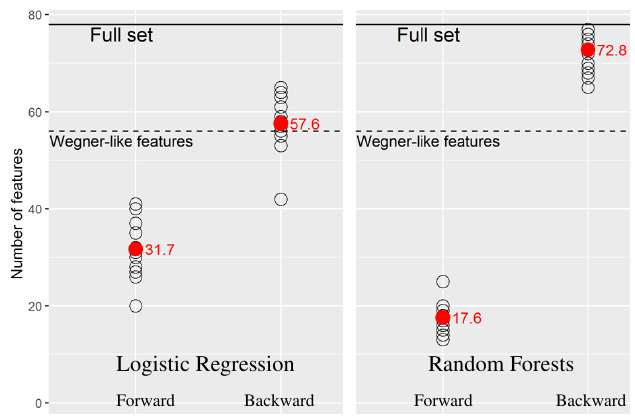
Figure 1: Cardinalities of the produced feature sets for different patches, indicated by black circles; the average cardinalities are depicted in red.